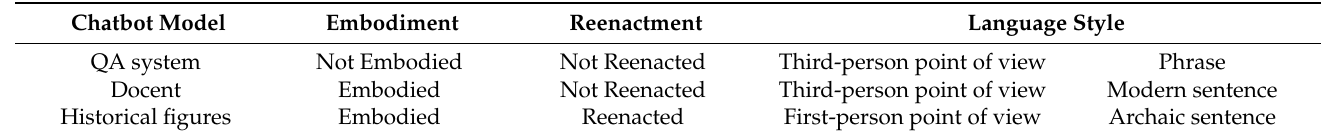
Figure 1. Appearance of three chatbot models. Table 2. Three chatbot models